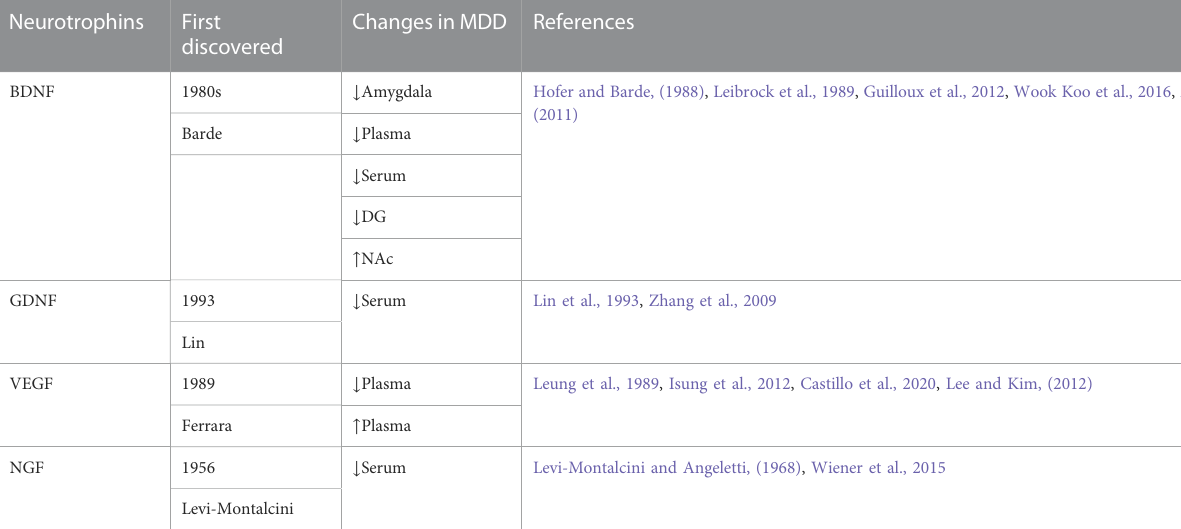
TABLE 1 Relationship between neurotrophins and the pathogenesis of